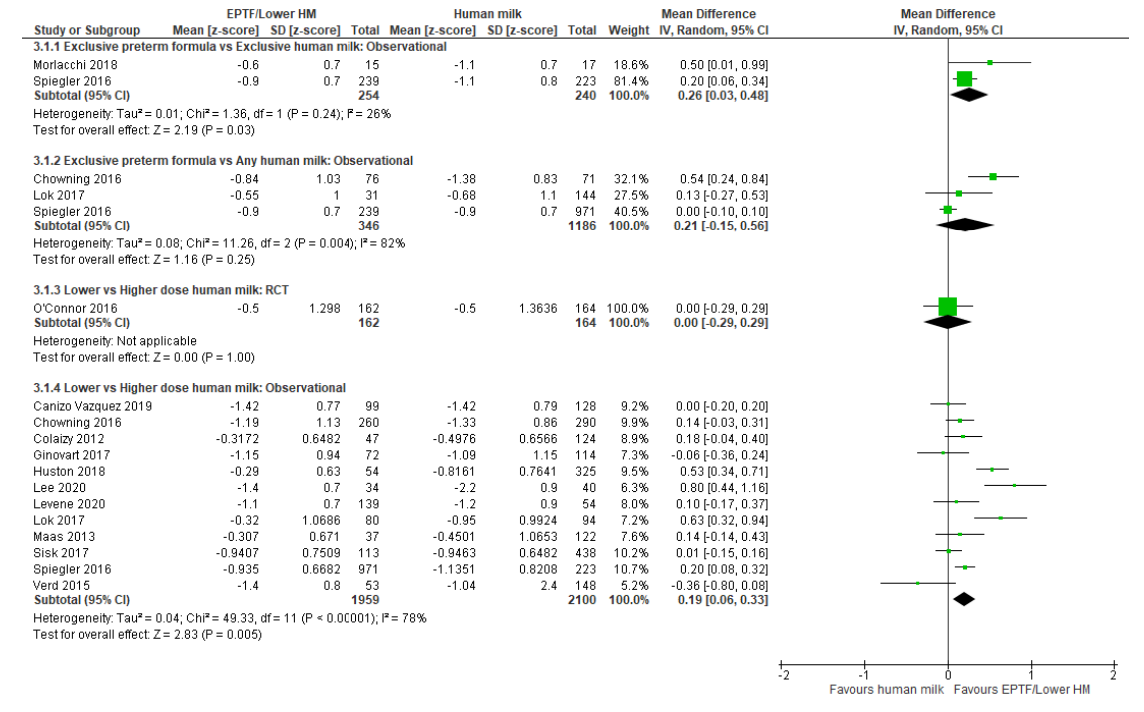
Figure 3. Forest plot of mean difference in change in weight z-scores and human milk intake.